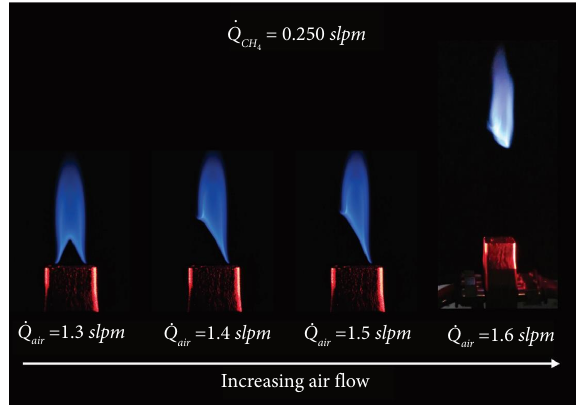
Figure 3: Flame blow out by increasing the airfow